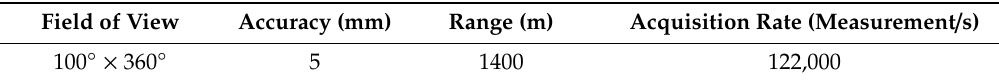
Table 1. Theoretical accuracy of RIEGL VZ-1000.